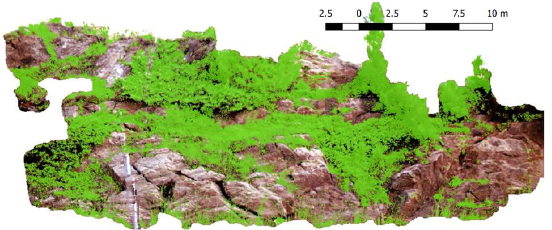
Figure 6. Points with vegetation